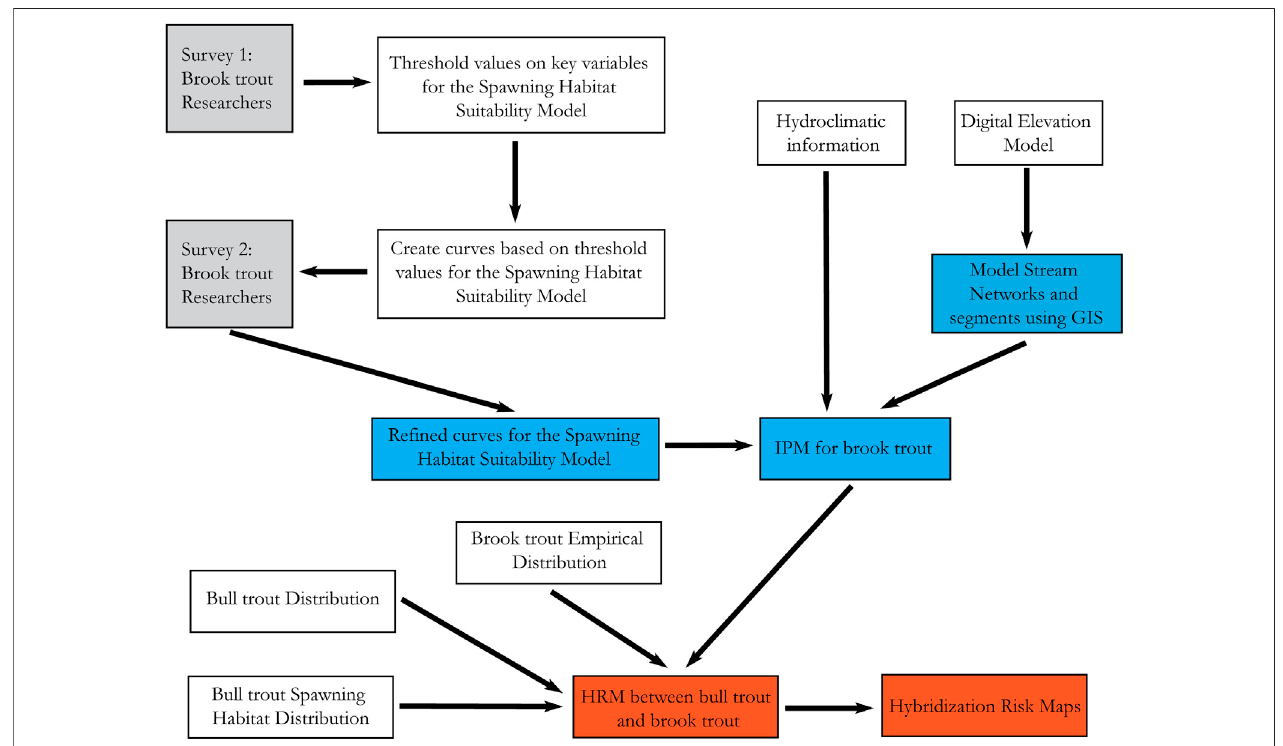
FIGURE 2 | Project work fl ow showing surveys (gray), data input (clear), Intrinsic Potential Model development (blue), and Hybridization Risk Model results with risk maps (red).